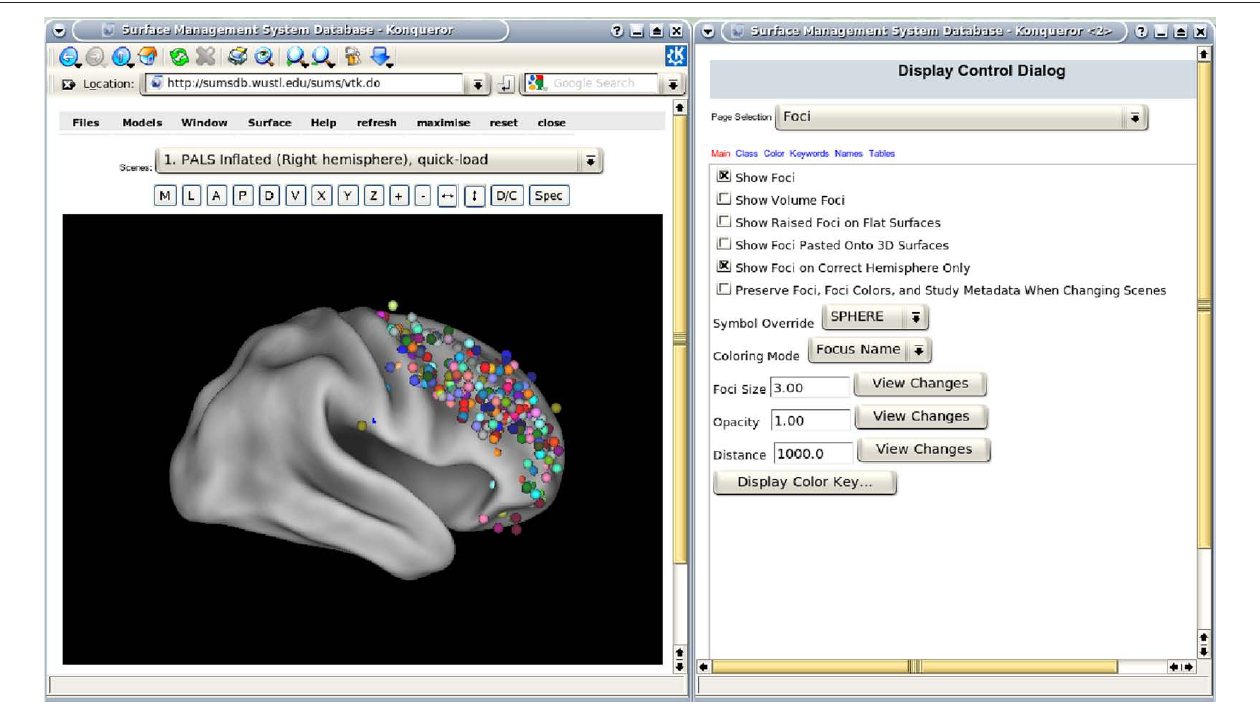
FIGURE 2 | WebCaret server-side display of returned coordinates from the Surface Management System Database (SumsDB) with a query on ‘middle frontal gyrus’. The right window offers some control over the rendering and the